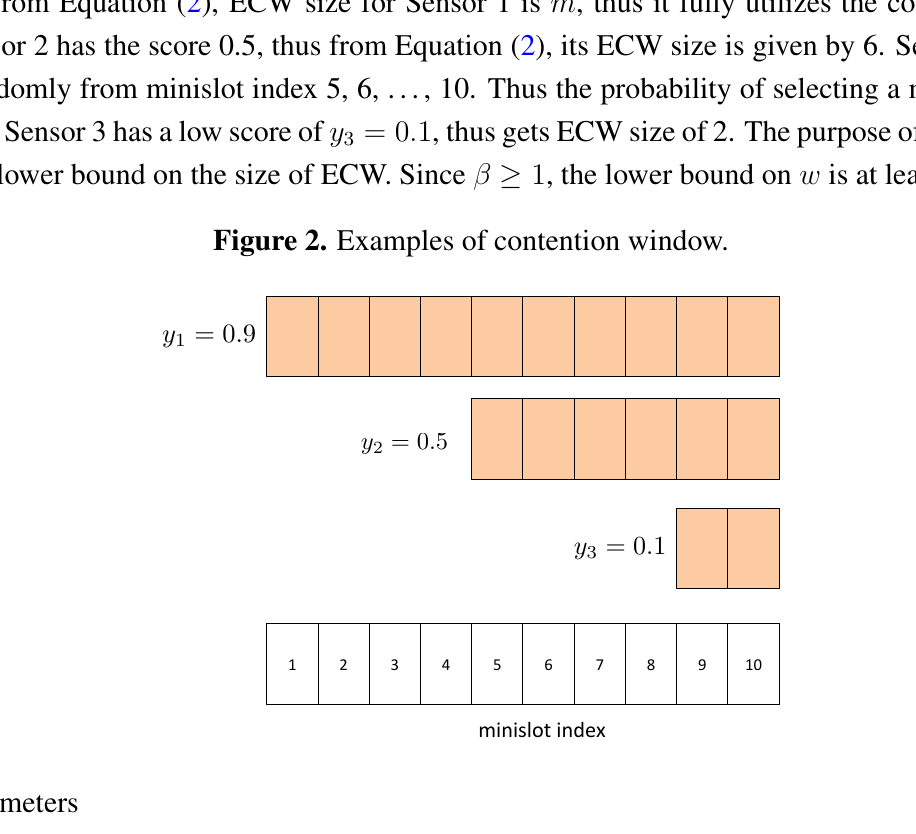
Figure 3. A plot of y γ for y